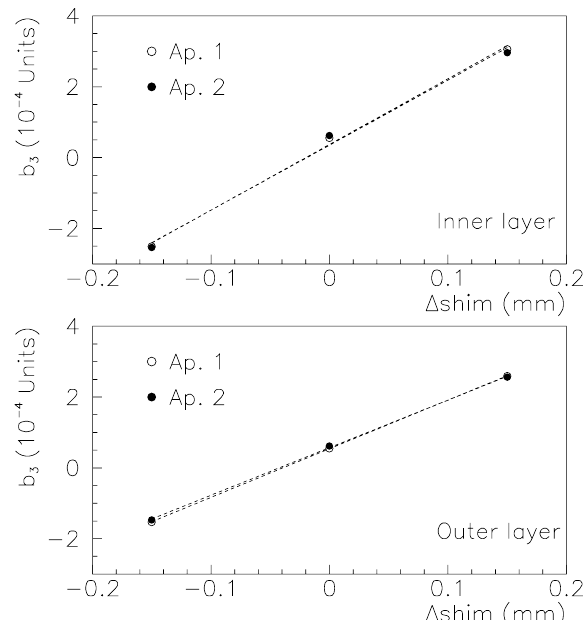
FIG. 7. b 3 ( 10 2 4 units) versus shim thickness variation (mm) for the inner and outer layers and for the two apertures (Ap. 1 and Ap. 2), experimental data, and linear fit.